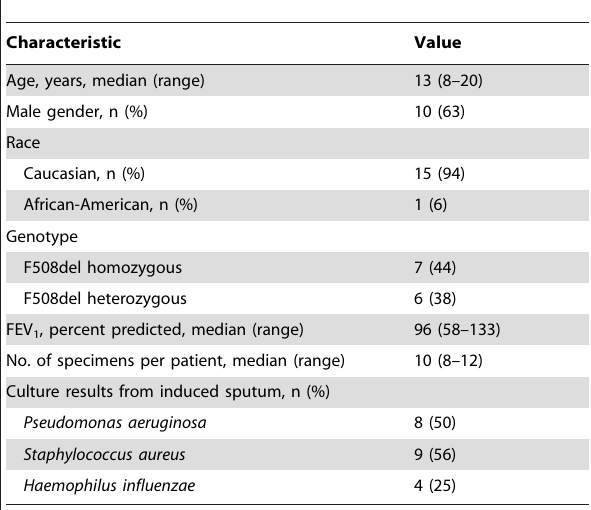
Table 1. Baseline subject characteristics (N